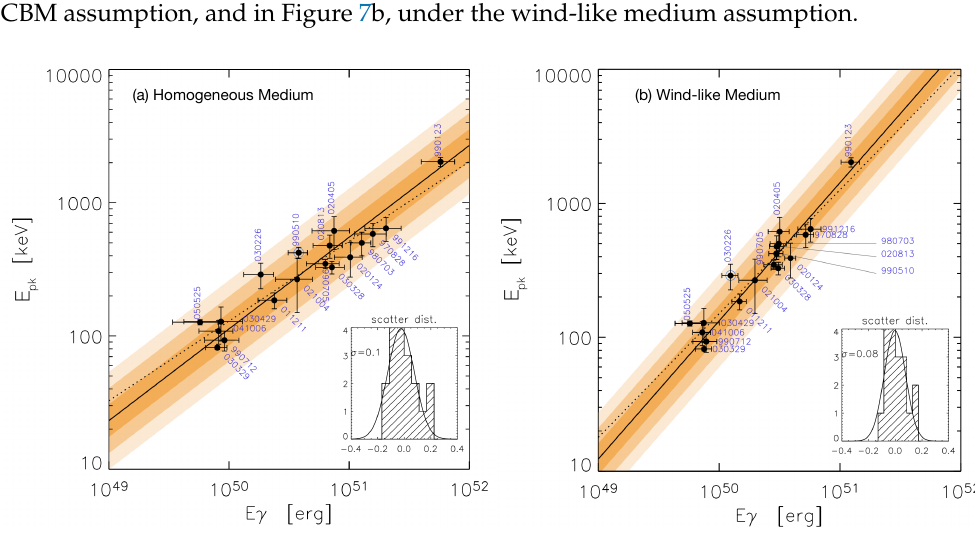
Figure 7. The Ghirlanda relationship(s) taken from Nava et al. [183]. In the panel ( a ), the relationship for the Ghirlanda relationship is shown, assuming a homogeneous circumburst density. The yellow regions denote the 1 σ , 2 σ , and 3 σ scatter from darkest shading to lightest shading. The scatter is measured with respect to the best fit line, plotted as the solid black line (Equation (22)), where uncertainties in both quantities were considered. The dotted line shows a simple regression analysis without considering the errors of each data point. The inset plot shows the scatter of the data with respect to the best fit line. The standard deviation of the best fit gaussian to the scatter distribution is also shown. Panel ( b ) is identical except the best fit relation is given by Equation (23) for the assumption of a wind-like CBM. Credit: Nava et al., A&A, 450, 471–481, 2006, reproduced with permission